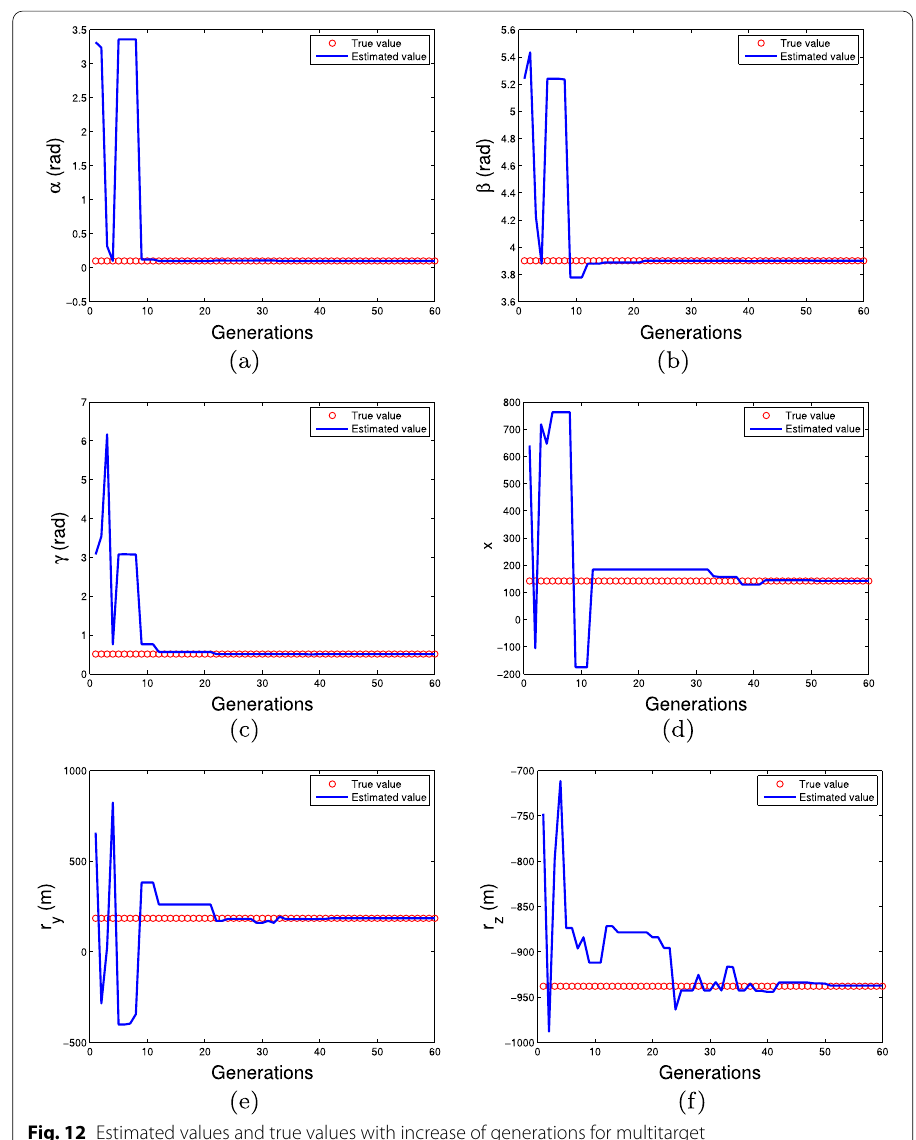
Fig. 12 Estimated values and true values with increase of generations for multitarget